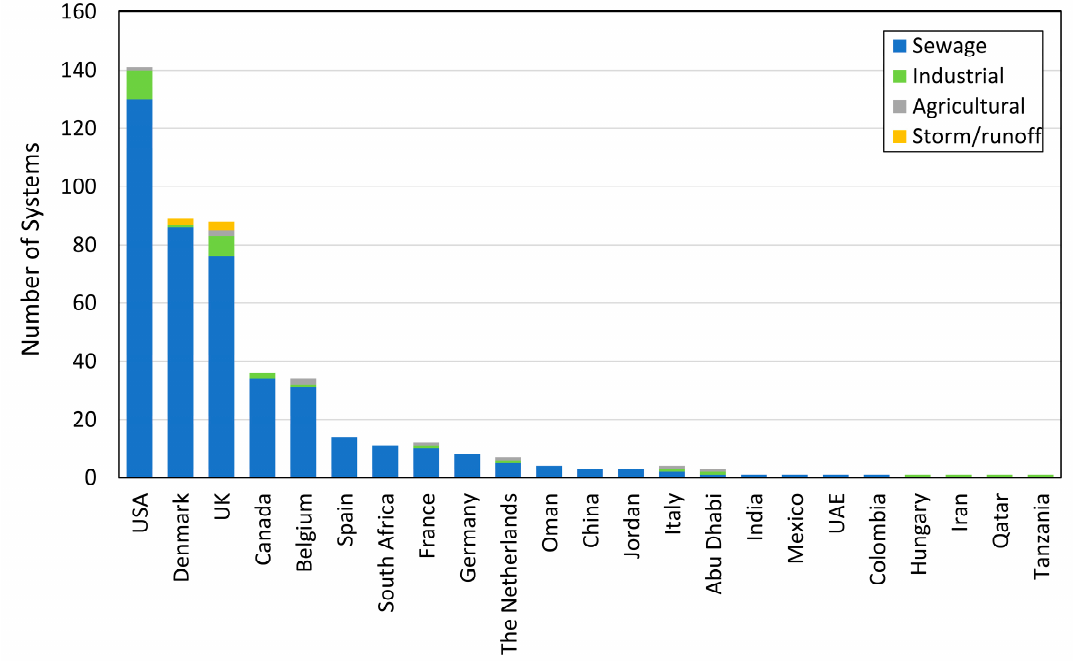
Figure 2. Types of wastewater treated by aerated treatment wetland systems as of June 2019.